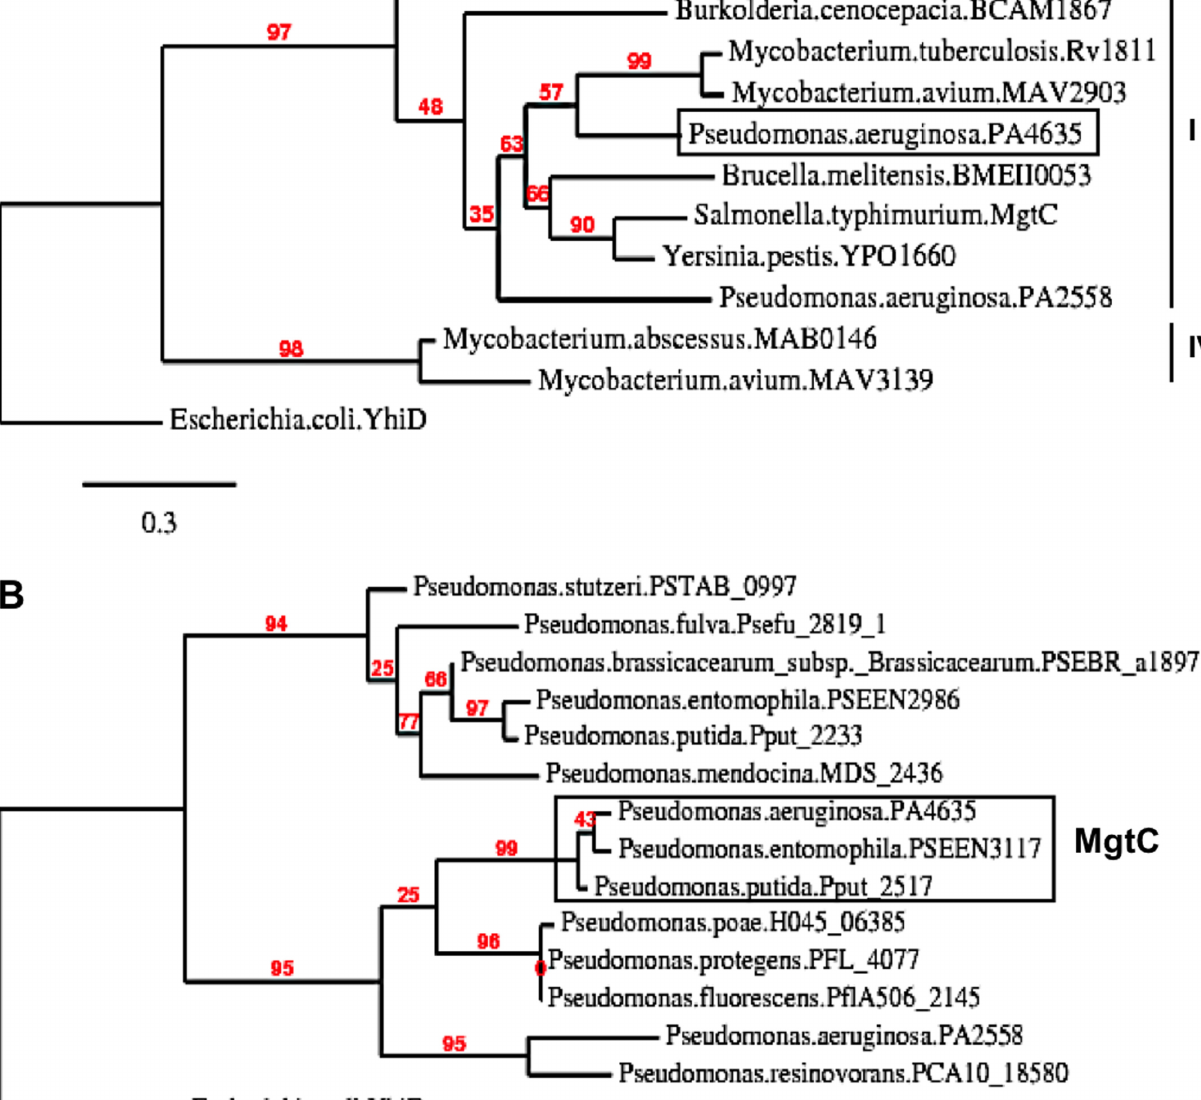
PLOS Pathogens | DOI:10.1371/journal.ppat.1004969 June 16, 2015 4 /